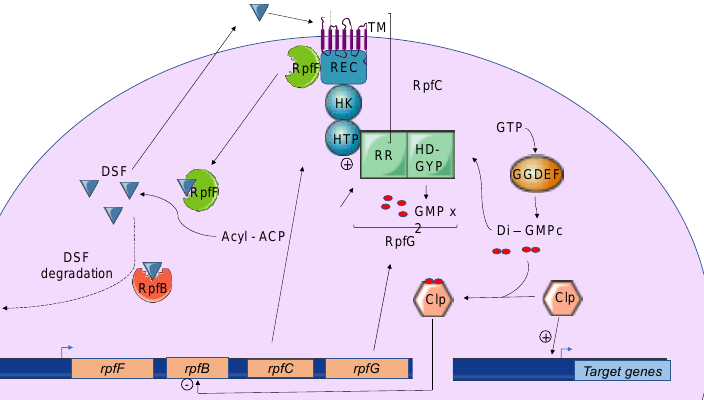
Figure 4. The Diffusible Signal Factor-mediated quorum-sensing (DSF-QS) system. In phytopathogenic bacteria, the DSF system is encoded by the rpf gene cluster. RpfF is a bifunctional enzyme involved in the production of DSF molecules. RpfB is proposed to be involved in DSF turnover. RpfC–RpfG is a two-component regulatory system that is involved in signal perception and trans- duction. RpfC is a DSF sensor that uses a phospho-relay mechanism to transfer the signal to the response regulator, RpfG. The N-terminal RR response domain of RpfG interacts directly with RpfC. Its HD-GYP domain then degrades cyclic di-GMP. RpfC can also bind to RpfF using its C-terminal REC domain and negatively regulates DSF biosynthesis. At a low cell density, (i) RpfC forms a com- plex with RpfF, blocking its enzymatic activity and inhibiting DSF signal biosynthesis, and (ii) cyclic density, RpfF is released and produces DSF signals, which allow the induction of QS regulation.